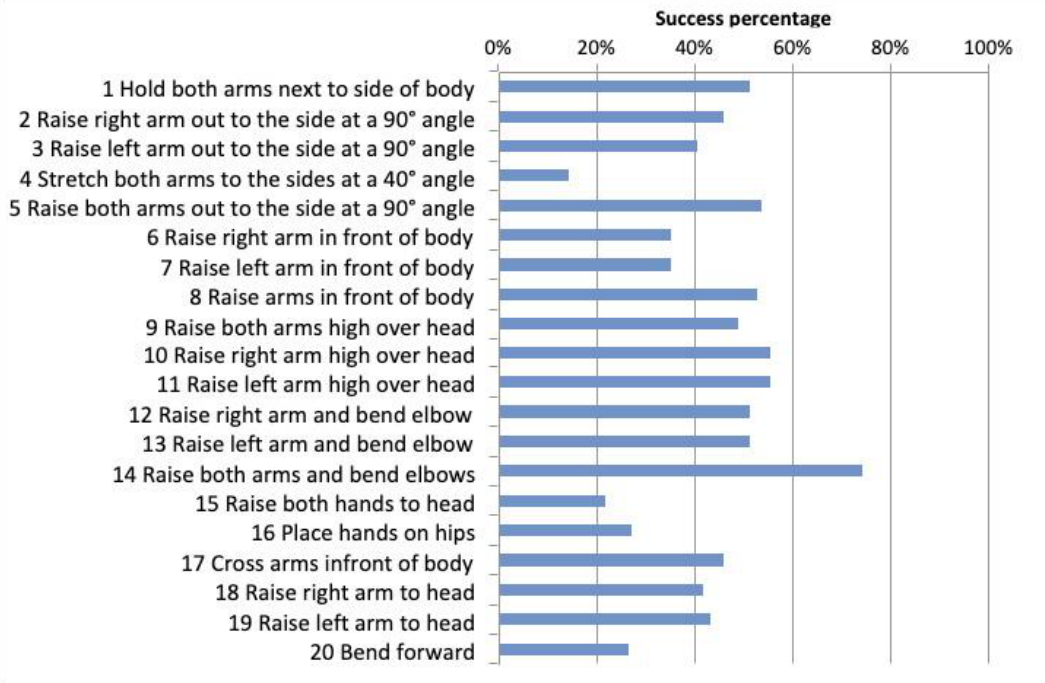
Figure 7. Success rate percentages by Kinect gesture. Table 4. Pearson’s Chi-square (χ 2 ) Test for Kinect gestures.